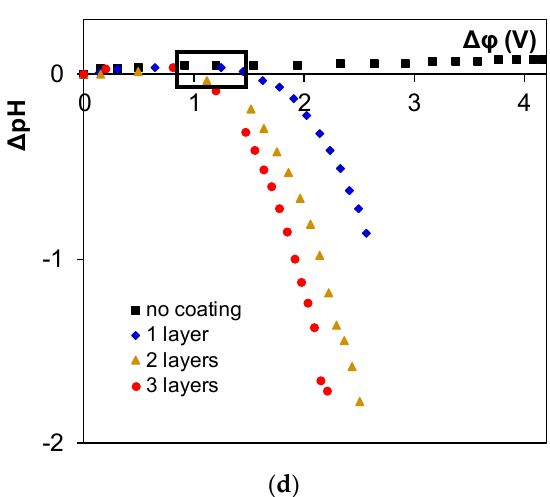
Figure 7. Dependence of the difference in pH between the exit and entrance of the desalination chamber formed by CMX cation exchange membranes and AEMs based on AMX-Sb ( a , c ) and MA-41P ( b , d ) on current density ( a , b ) or potential drop over the membrane ( c , d ). Crosses show the approximations of pH made for experimental limiting current densities based on pH values registered for the two closest current densities. Squares denote the commercial membranes, diamonds represent the membranes with one layer of coating, triangles represent the membranes with two layers of coating, and circles represent the membranes with three layers of coating.